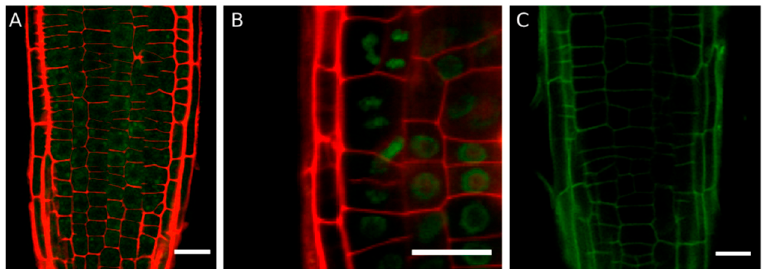
Figure 3. Subcellular localization of the TEB protein in meristematic root cells synchronized with hydroxyurea. ( A ) Arabidopsis pTEB::TEB-GFP seedlings were treated with hydroxyurea for 16 h, and a di ff use pattern of GFP in meristematic cells of the cortex was observed. The cell wall was stained with propidium iodide (red). ( B ) After 18 h of hydroxyurea treatment, GFP was detected as a ring surrounding the nucleus in the cortex cells. ( C ) TEB was located in the cell wall after 19 h of hydroxyurea treatment. Hydroxyurea stops DNA synthesis and after 16–17 h most of the cells are at the G2 / M transition and at 18–20 h cytokinesis occurs according to Cools et al. [31]. Seedlings were sown in MS medium and transferred on day 6 to MS medium with hydroxyurea for 16–20 h. The images are all section images. Scale bars = 20 µ m. The Arabidopsis transgenic plants were obtained as described in Salazar-Iribe et al.